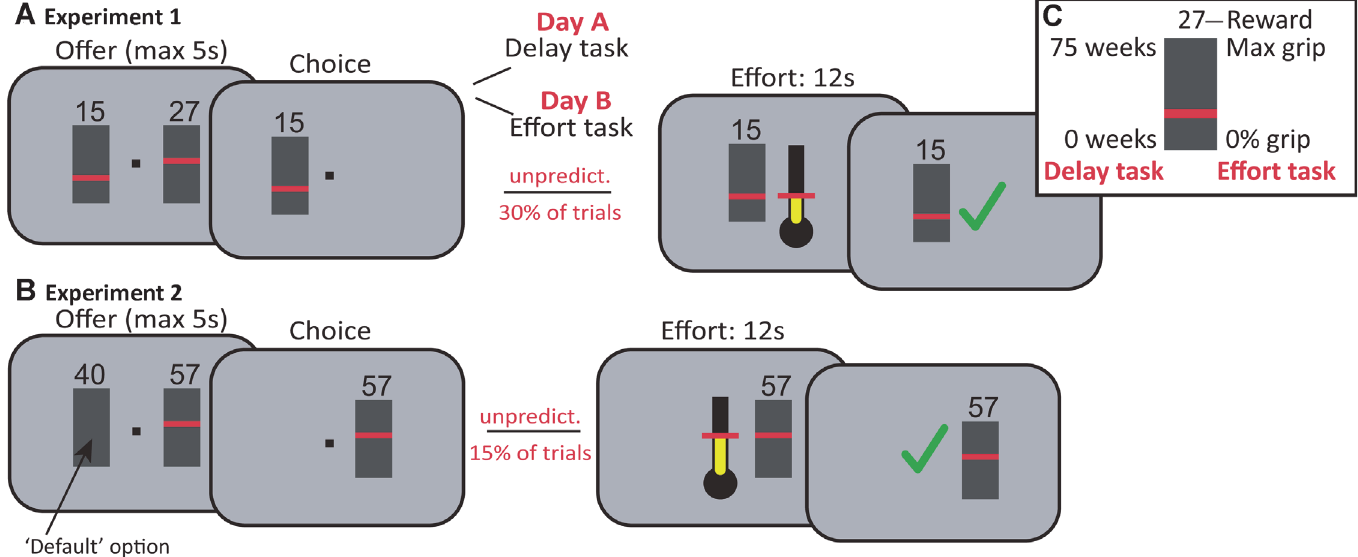
Fig 1. Task: Effort and delay discounting task. A, In Experiment 1 , participants chose between a higher-reward/higher-cost (HRHC) option and a lower- reward/lower-cost option (LRLC; reward magnitude = number; cost level = height of red bar). Magnitudes and costs of both options varied from trial to trial. To directly dissociate effort and delay discounting, decision costs entailed a fixed-duration 12s power grip adjusted to individuals ’ maximum grip force on one day (effort task), and a delay to reward (0 – 75 weeks) on the other day (delay task). Efforts were exerted on an unpredictable 30% of trials ( * 15% per hand). B , In Experiment 2 , participants made choices between a ‘ default ’ option of 40p (block1) or £2 (block2) available for no effort (left) and an alternative option of varying effort and magnitude (right). Participants ’ points of subjective indifference were obtained by independently adjusting the magnitude of the alternative option for six levels of effort ([0.15 0.25 0.4 0.55 0.75 1]) across trials, using interleaved staircases. Again, decision costs entailed a 12s grip at the indicated force level. Efforts were exerted using the right hand on an unpredictable 15% of trials, thus avoiding fatigue, and feedback was given upon completion of the required force level for 12 seconds. C, The height of the red bar signaled the cost, with the top of the grey box, i.e. the maximum cost, corresponding to 75 weeks (delay task, Exp 1) or a participant ’ s maximum 12s-grip force. All data figures display costs according to this scale. The reward size was displayed as a number above the cost display. The information in this box was explained to the participant, but was not visible on the screen.